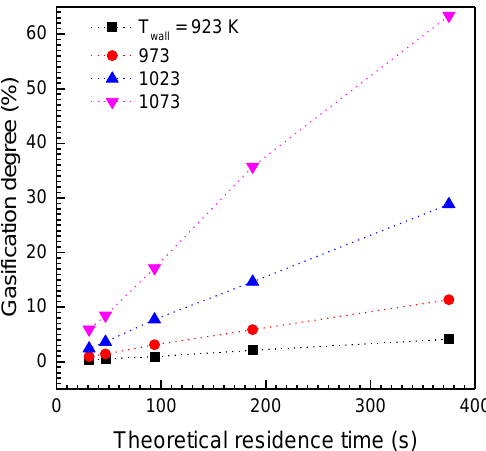
Figure 7. Average cross-sectional gasification degrees of graphite particle flow at the screw reactor outlet.